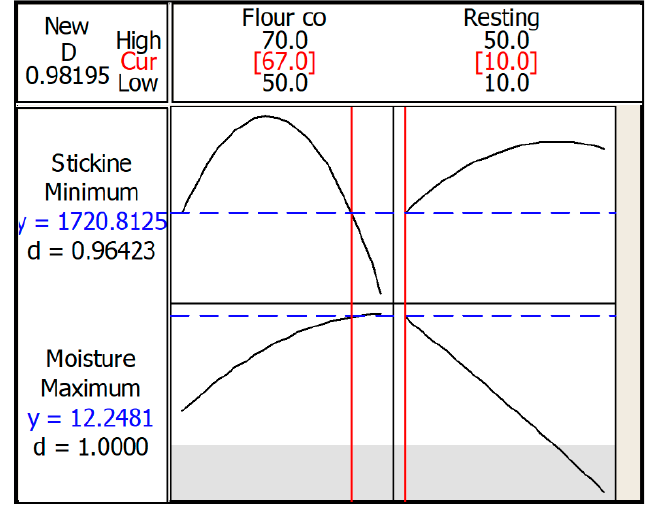
Figure 6. Optimization plot for optimum combination of flour content and resting time.